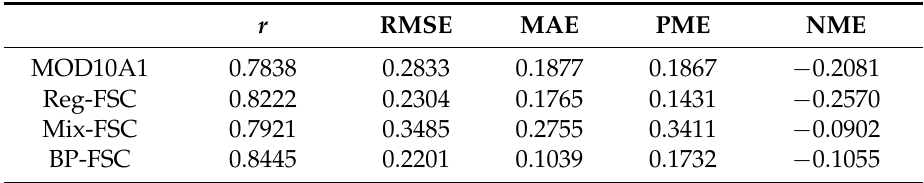
Table 6. r , RMSE, MEA, PME and NME statistics for the three FSC models and the MOD10A1 FSCs in the validation sub-regions